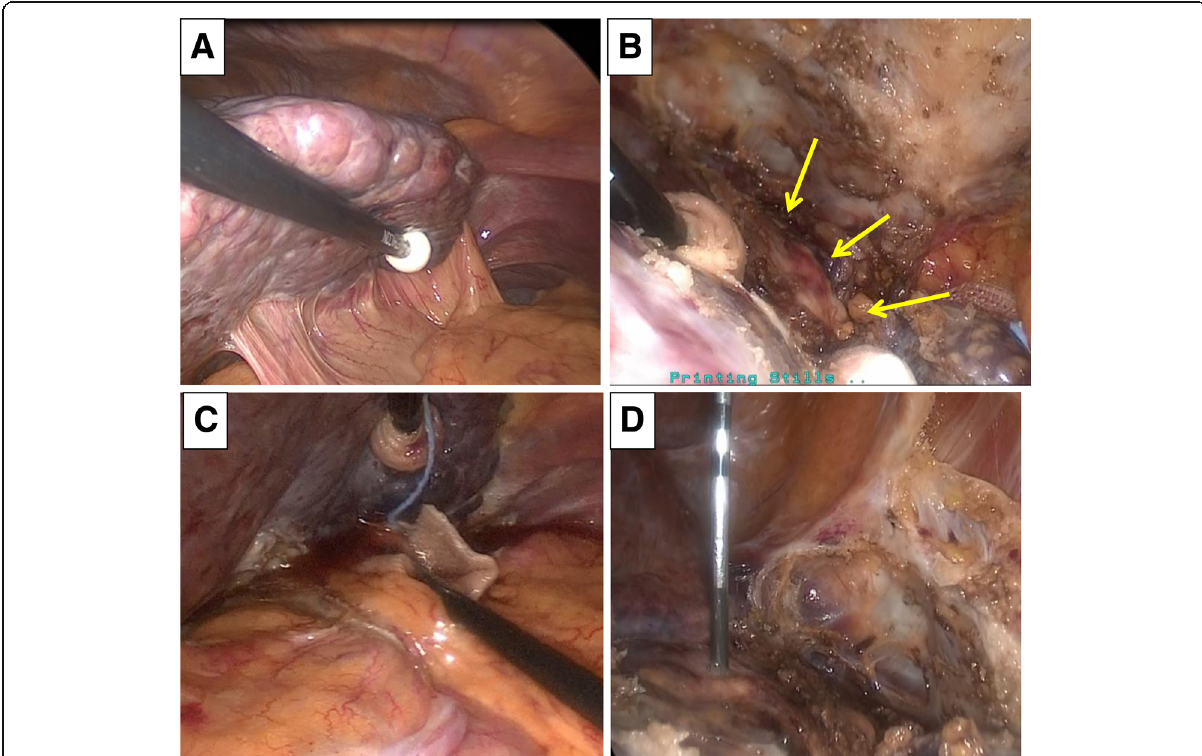
Fig. 2 RFA laparoscopic procedure. a The left lateral lobe of the liver adhered severely to the diaphragm, stomach, and lesser omentum. b The HCC tumor was located just below the heart (arrows). c Gauze and some water were placed between the stomach and left lateral lobe of the liver to avoid thermal injury of the stomach. d A cool-tip needle was inserted vertically into the liver to avoid injuring the heart